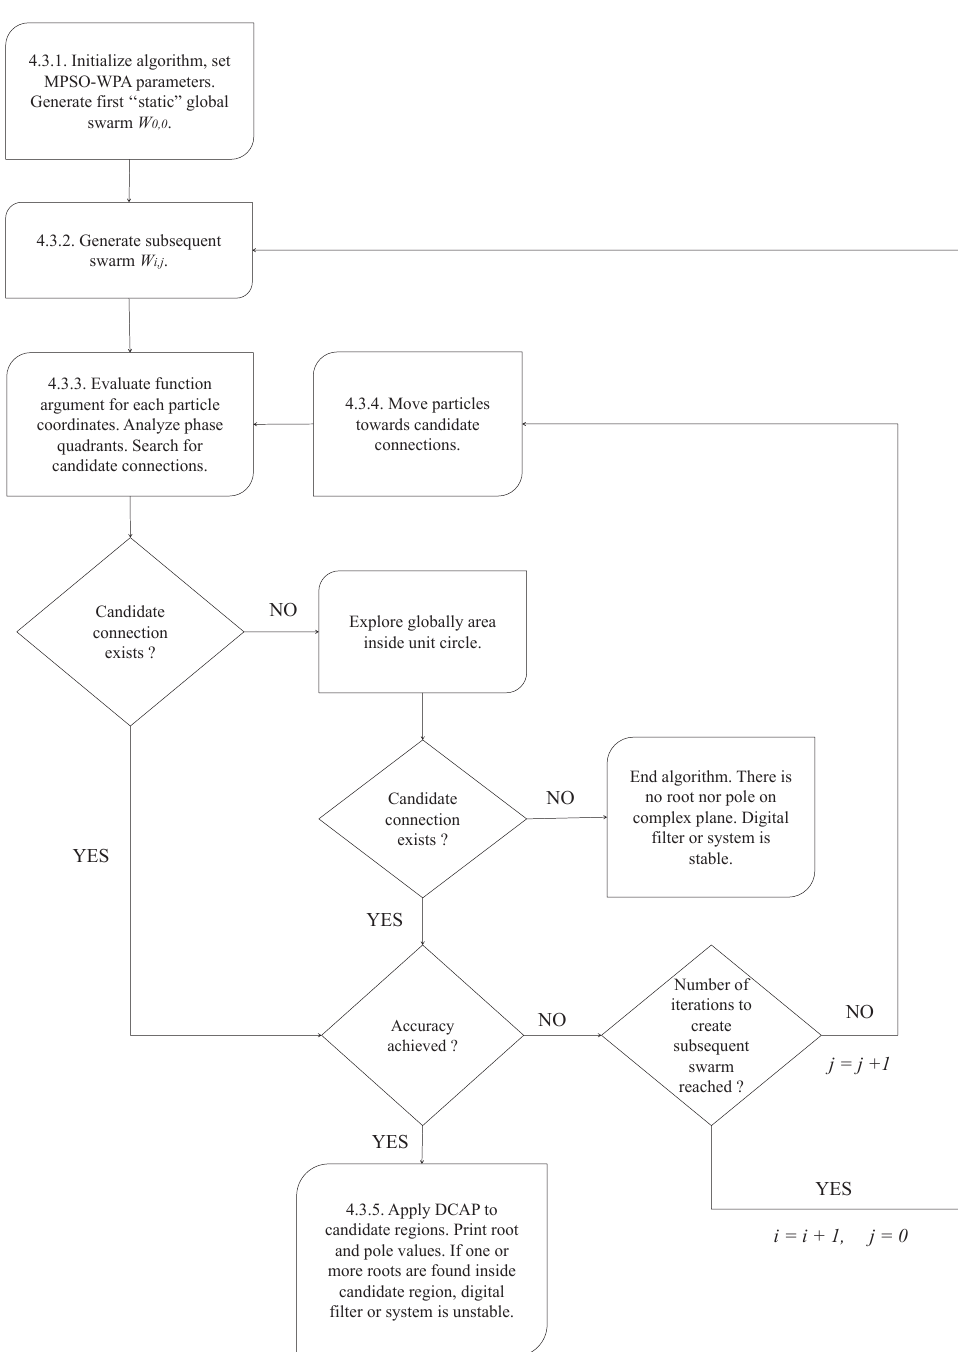
Figure 4. Flowchart of stability test with the multimodal particle swarm optimization with phase analysis (MPSO-WPA)